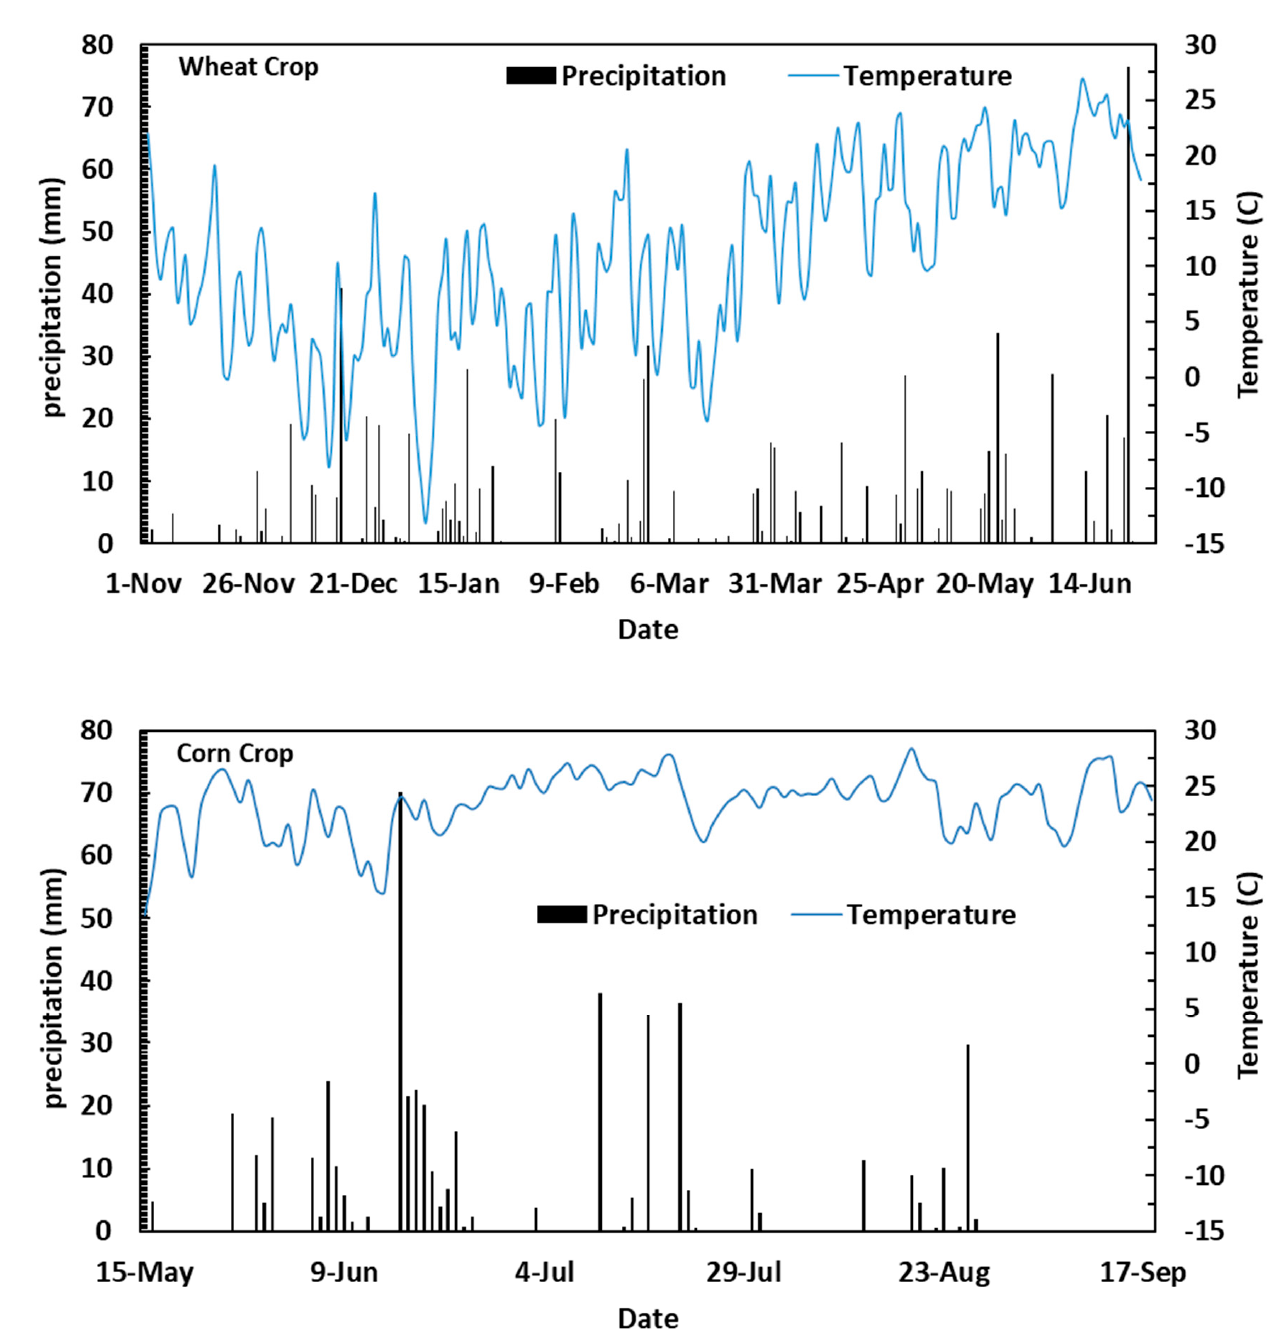
Figure 1. Daily precipitation and mean air temperature during the wheat growing season in 2016–2017 and corn growing season in 2019.